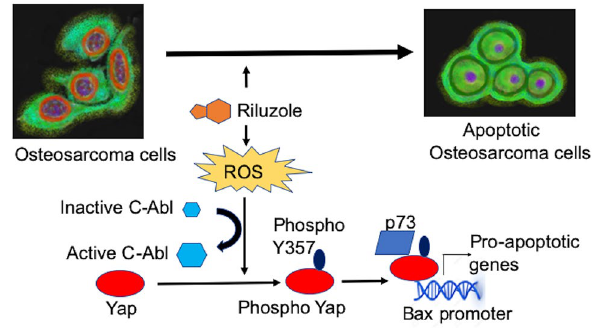
Figure 7. Mechanism of action of Riluzole-induced apoptosis in osteosarcoma. A schematic representation of the mechanism of Riluzole action is